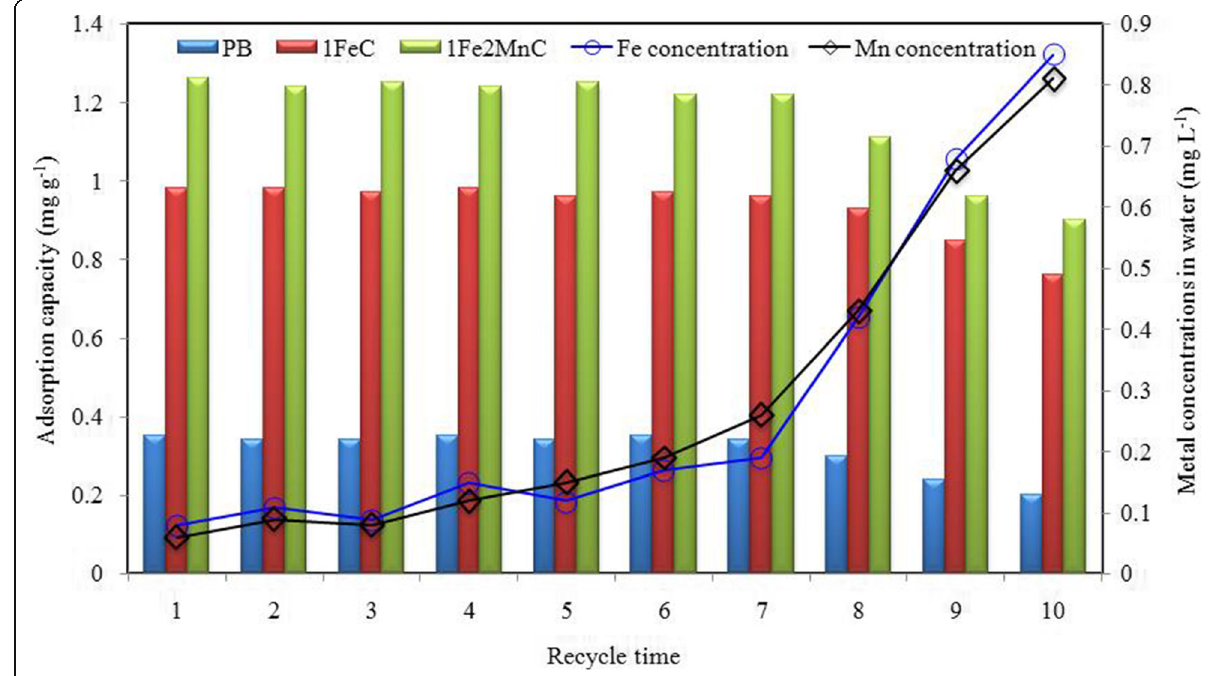
Fig. 10 The uptake of As (III) by biochar in consecutive adsorption-desorption cycles at initial concentration 1.0 mg L −